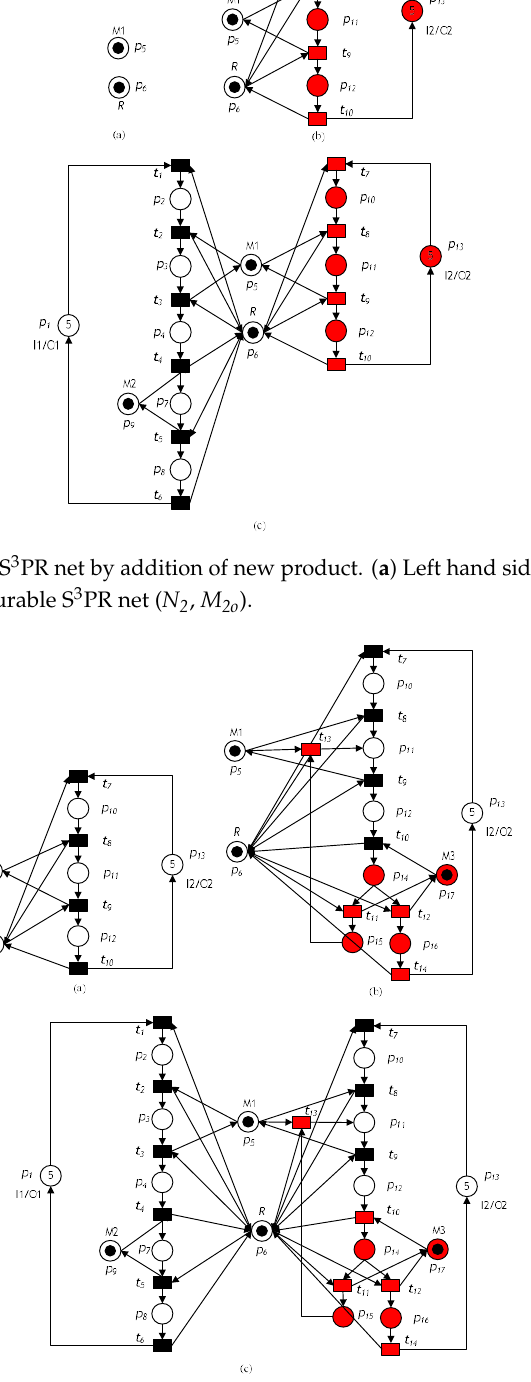
Figure 5. A reconfigured S 3 PR net by rework. ( a ) Left hand side net L. ( b ) Right hand side net R. ( c ) A reconfigurable S 3 PR net (N 3 , M 3o ).